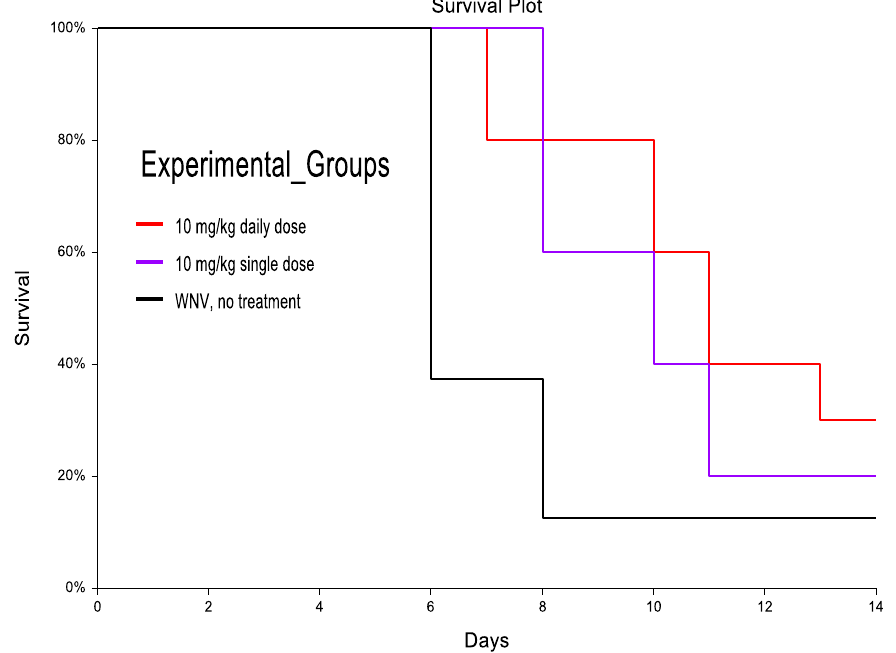
Figure 4. Kaplan–Meier analysis in treated and untreated mice exposed to WNV-NY99. Red: WNV- infected + 10mg/kg daily dose beginning at symptom onset (N = 10); Purple: WNV-infected + 10 mg/kg single dose at symptom onset (N = 5); Black: WNV-infected with no treatment (N = 8).